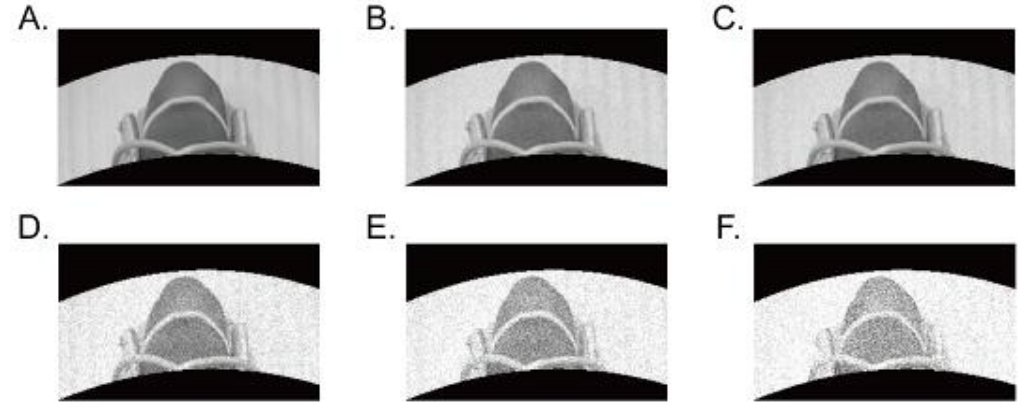
Figure 3. Snapshots from video clips with superimposition of different levels of Gaussian noise: Zero ( A ), 0.1 ( B ), 0.2 ( C ), 0.3 ( D ), 0.4 ( E ) and 0.5 ( F ). As can be seen in